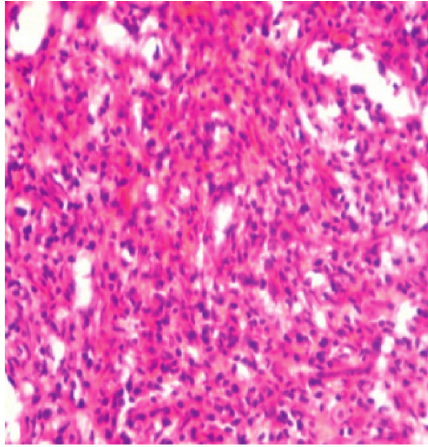
Figure 5: Third histology report of Hodgkin’s lymphoma (hae- matoxylin and eosin stain).